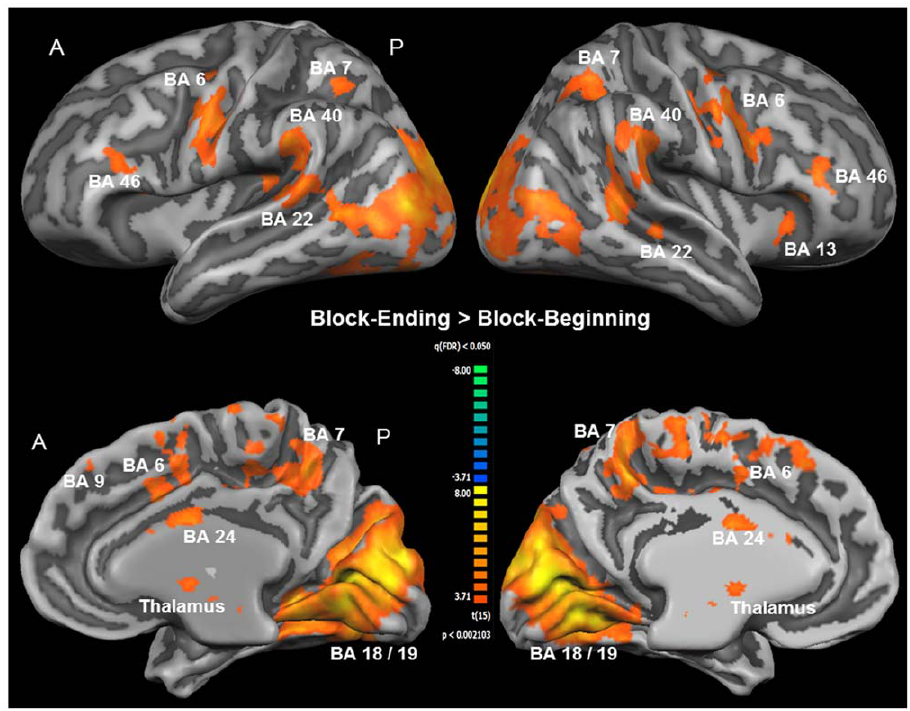
Figure 6. Whole-brain results of the second part of the fMRI analysis (RFX-GLM; n =16). All clusters of activation shown here are the result of the contrast Block-Ending . Block-Beginning, specifically representing how the intrinsic alertness task was processed in the absence of any potential external cue, such as the change of the screen color happening at the beginning of the task block. For visualization, results were projected onto the optimized 3D surface reconstruction, representing the average brain of all participants. All activations were thresholded at q(FDR) , 0.05 (t=3.71). Brain areas showing higher activation during the ending than during the beginning of the intrinsic alertness task included the right and left fronto-parietal cortices, the thalamus and the ACC, among others. For a complete list of functional activations resulting from the contrast Block- Ending . Block-Beginning see Table 3. (A=anterior; BA=Brodmann area; P=posterior) .